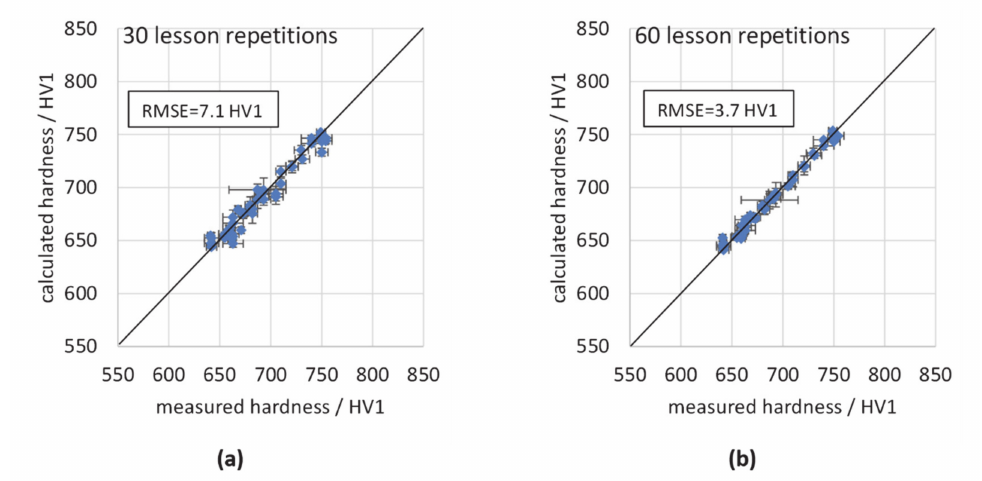
Figure 12. Correlation of micromagnetic determined and actual measured hardness of the training data set after 30 ( a ) and 60 ( b ) repetitions of the training lesson using artificial neural networks